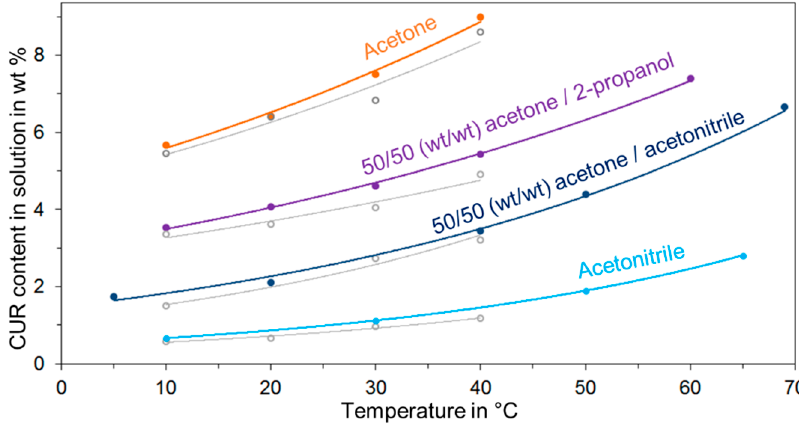
Figure 6. Comparison of solubility curves determined for pure CUR (empty circles, grey curves), and CUR in presence of the main impurities (solid circles, colored curves). Symbols represent experimental data, fitted curves serve as guide to the eyes.